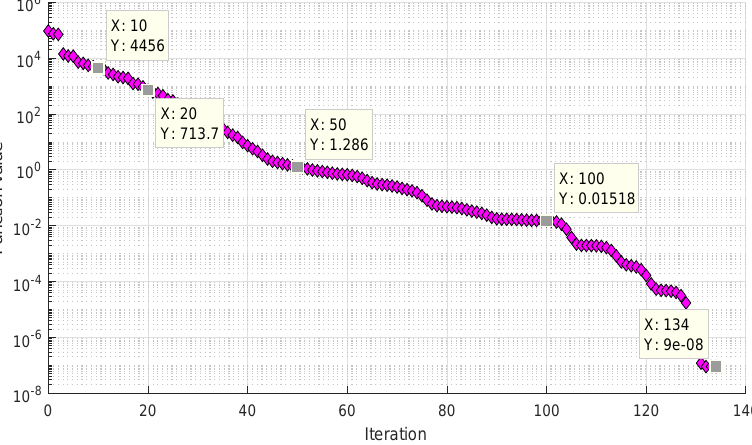
Figure 4. Objective function J minimization at the second step of two-step power system state and line temperature estimation